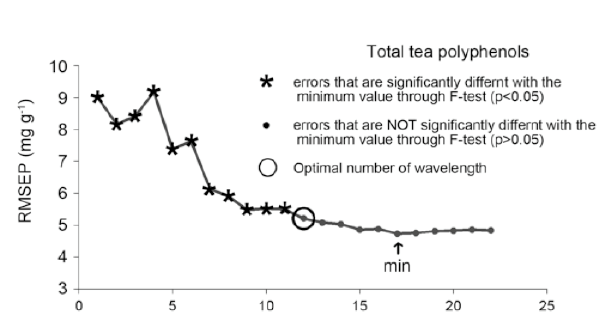
Figure 4. Choice of the optimal number of wavelength (circled positions) by successive projections algorithm for the prediction of tea polyphenols. The criterion is to find a minimum number of wavelengths for which the errors is not significantly larger than the lowest one. This is determined by an